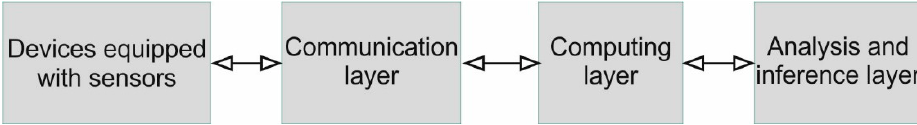
Figure 1. Simplified IoT architecture.